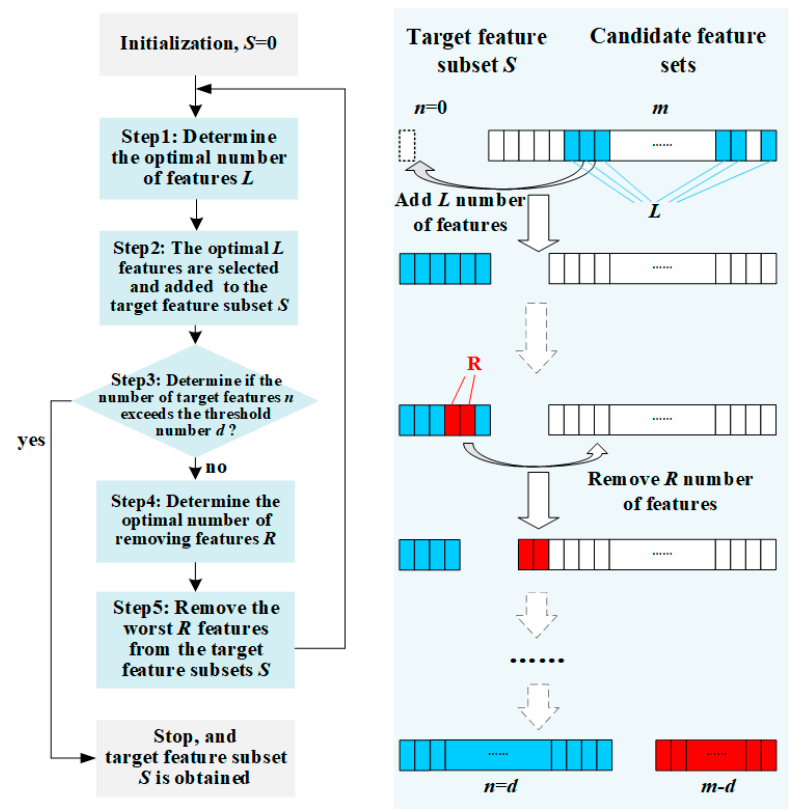
Figure 3. Flowchart of the SFFS algorithm.